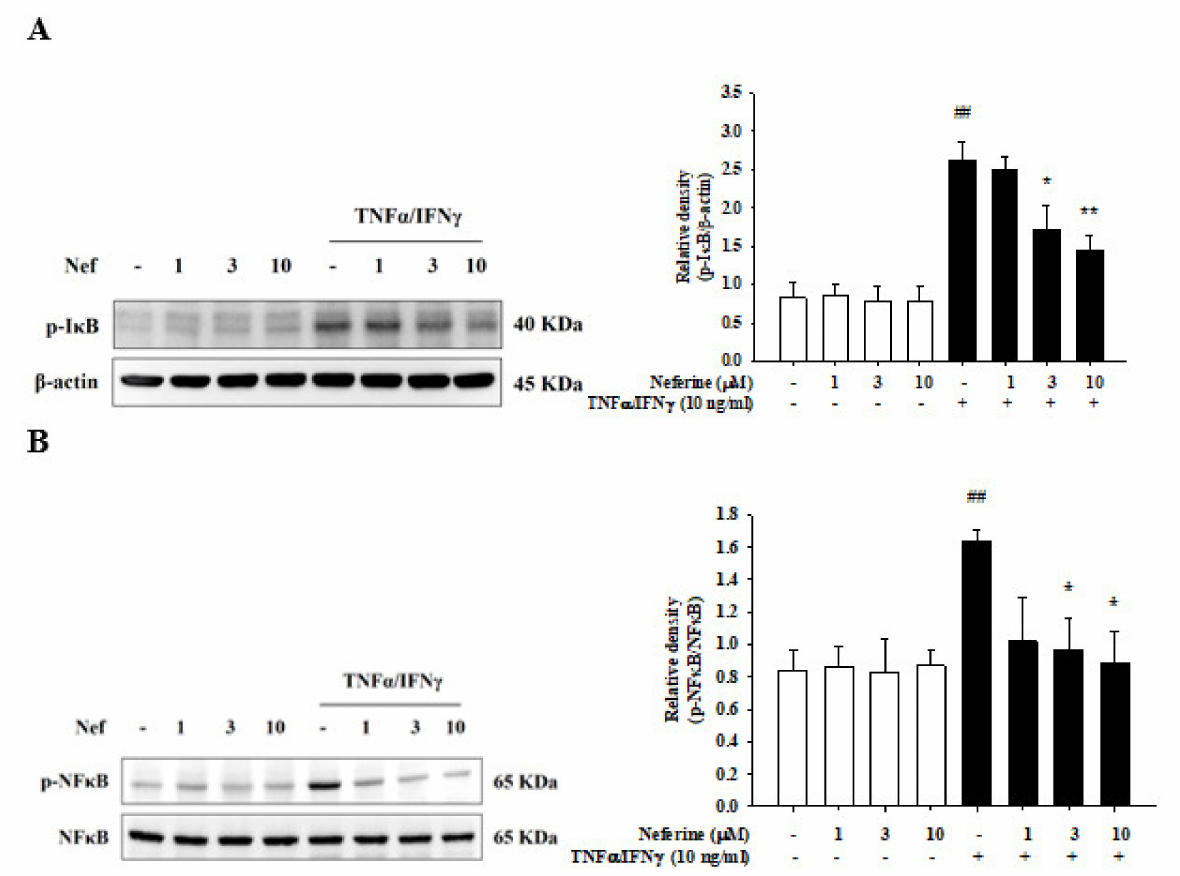
Figure 5. Neferine inhibited TNF- α /IFN- γ -induced I κ B ( A ) and NF- κ B ( B ) activation in HaCaT cells. Cells were pretreated with different concentrations of neferine (1, 3, and 10 µ M) for 20 min and then were treated with TNF- α /IFN- γ (10 ng/mL) for 30 min. Western blots were analyzed quantitatively. Values represent the mean ± SEM from three independent experiments. ## p < 0.01 compared with the no-treatment condition; * p < 0.05 and ** p < 0.01 compared with the TNF- α /IFN- γ treatment